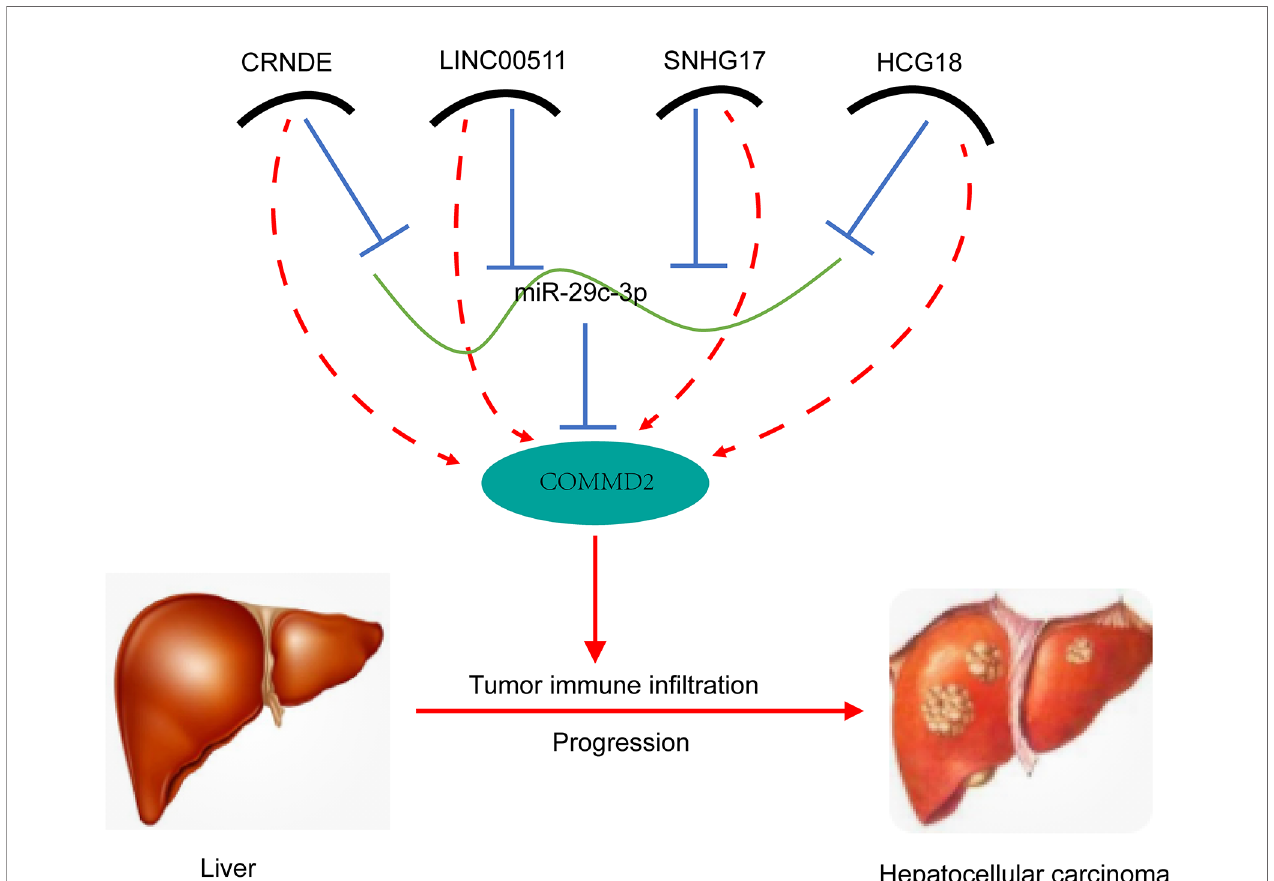
FIGURE 12 | Model of the CRNDE/LINC00511/SNHG17/HCG18-miR-29c-3p-COMMD2 axis in LIHC